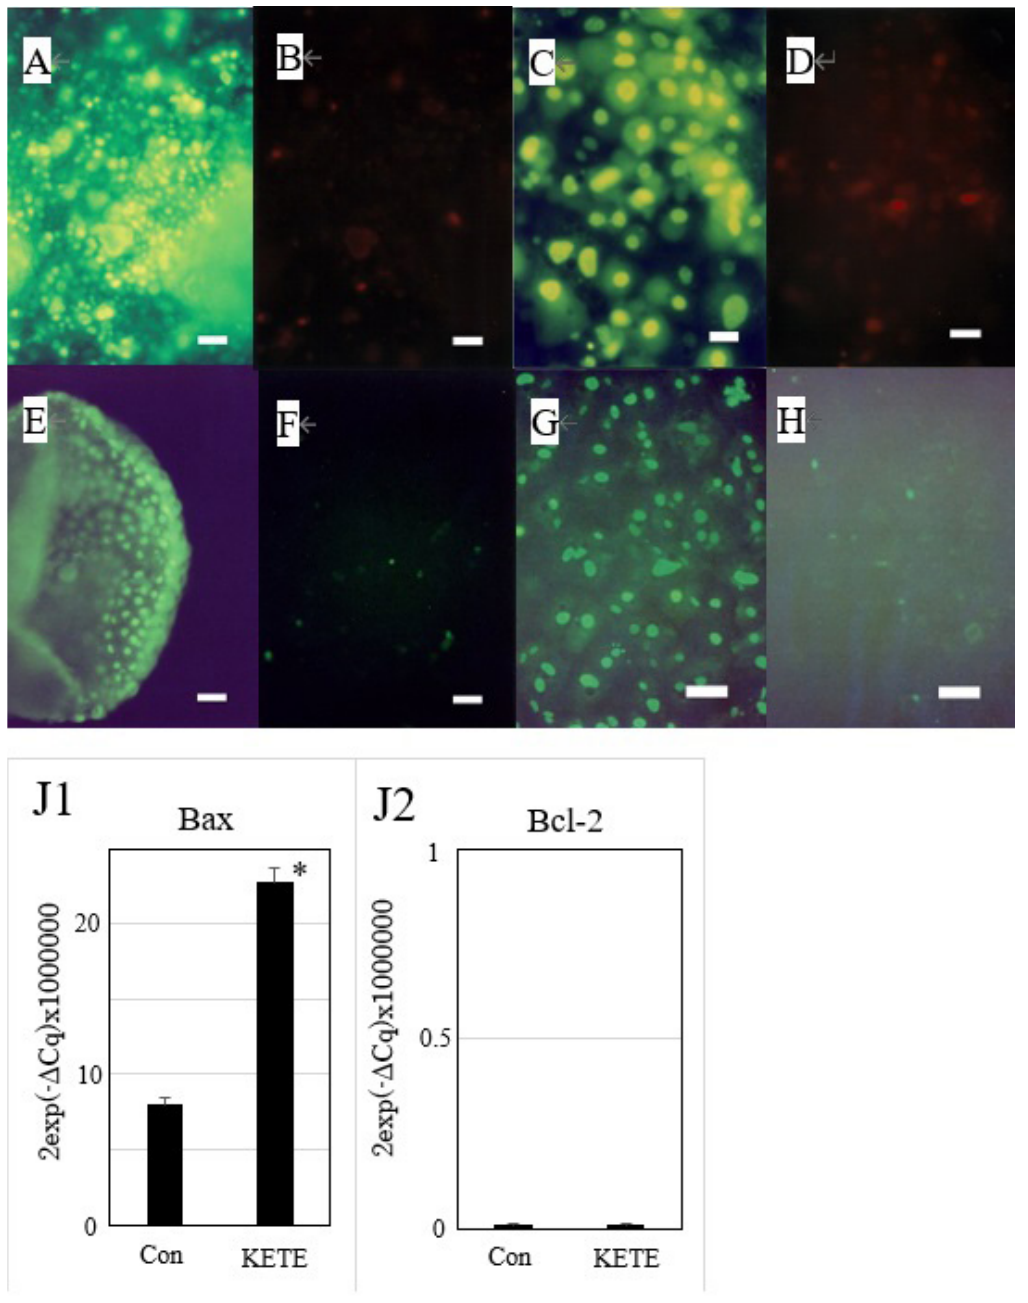
Figure 4. Induction of apoptosis of trophoblast colony in the presence or absence of feeder cells (fibroblasts derived from the placentome) by 12- KETE. Double staining of trophoblast colony without (A, B) (n = 3) or with (C, D) (n = 3) feeder cells by YOPRO-1 (A, C) or PI (B, D), 4 h (A, B) or 5 h (C, D) after 12-KETE treatment (40 μM), (white bars in A, B: 50 μm, in C, D: 25 μm). Detection of DNA fragmentation in trophoblast colony in the absence (E, F) (n = 1) or presence (G, H) (n = 3) of feeder cells. (E) At 19 h after 40 μM of 12-KETE, (F) No addition of 12-KETE, (white bars: 50 μm), (G) At 24 h after 40 μM of 12-KETE, (H) No addition of 12-KETE, (white bars: 50 μm). (J1, J2) qPCR results of Bax and Bcl-2 gene expression. * p<0.05. Replications (n = 3) of experiments showed the same results. 12-KETE, 12-oxo-5Z,8Z,10E,14Z-eicosatetraenoic acid; qPCR, quantitative polymerase chain reaction; Bax , Bcl-2 associated X protein; Bcl-2 , B-cell/CLL lymphoma